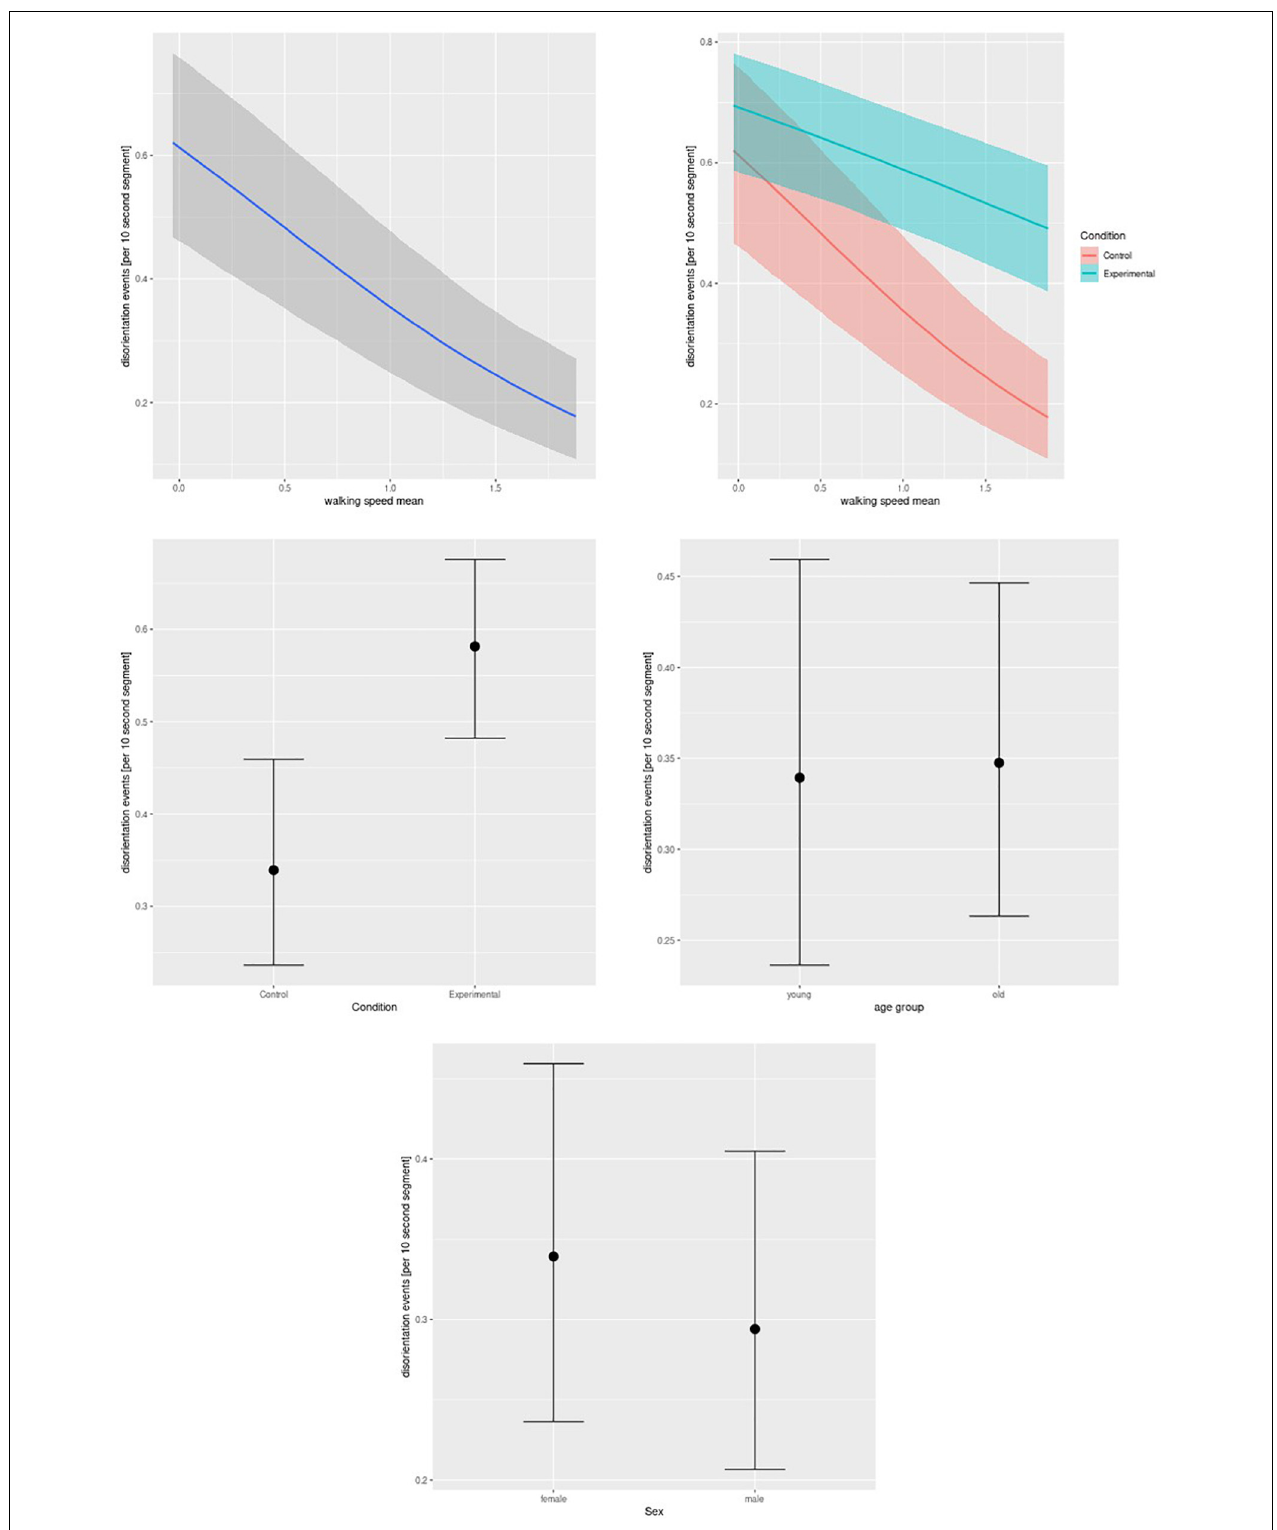
FIGURE 3 | Real-time data, walking speed. Bayesian mixed-effect logistic regression of disorientation events on mean walking speed (main effect, upper left and interaction effect with condition, upper right), condition (experimental or control, middle left), age group (middle right), and gender (lower row). The graphs feature mean effects and 95% credibility